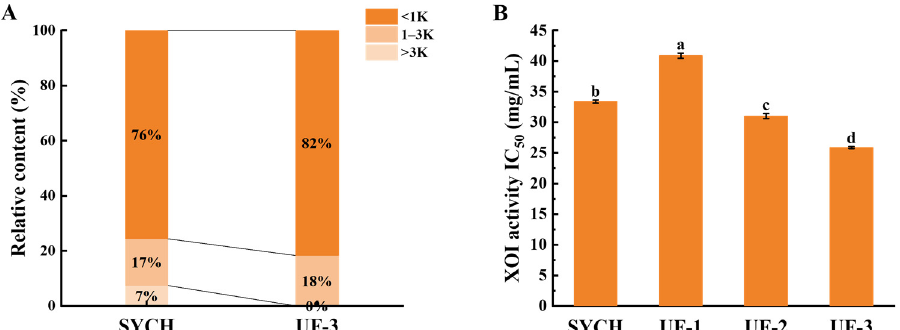
Figure 2. Molecular weight (MW) and XOI activity IC 50 of papain hydrolysates from small yellow croakers at 6 h. ( A ) MW distributions and relative contents of different samples. ( B ) XOI activity IC 50 of SYCH and three fractions after ultrafiltration. Different letters (a–d) among samples indicate significant differences ( p < 0.05).